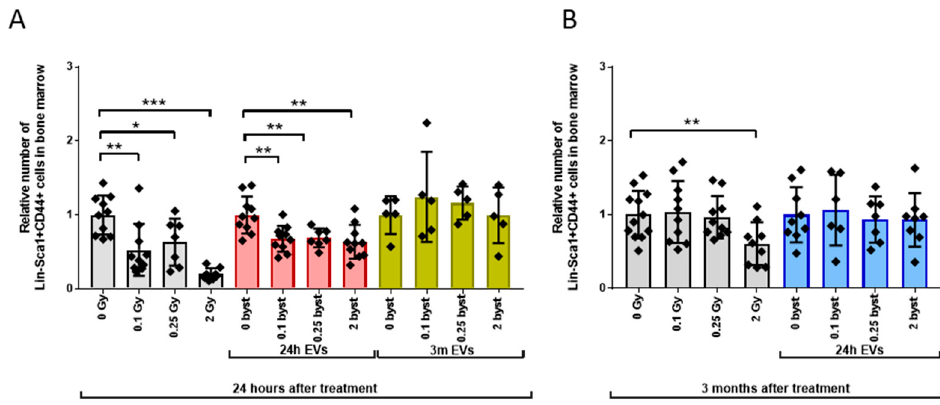
Figure 8. Short-Term Direct Irradiation and Extracellular Vesicle-Mediated Bystander Effects Affecting the Mesenchymal Stromal Cell Pool Are More Severe than Long-Term Effects. Irradiation, extracellular vesicle treatment and bone marrow cell phenotyping was done as described in the Materials and Methods section. Lin-Sca1+CD44+ cells were considered mesenchymal stromal cells. ( A ) Relative changes in mesenchymal stromal cell numbers were evaluated 24 h after treatment. Grey bars represent total-body irradiated mice; red bars represent mice treated with bone marrow-derived extracellular vesicles isolated from mice 24 h after irradiation; yellow bars represent mice treated with bone marrow-derived extracellular vesicles isolated from mice 3 months after irradiation. ( B ) Relative changes in mesenchymal stromal cell numbers were evaluated 3 months after treatment. Grey bars represent total-body irradiated mice; blue bars represent mice treated with bone marrow-derived extracellular vesicles isolated from mice 24 h after irradiation. Bars represent mean values of relative mesenchymal stromal cell numbers, dots show individual values, error bars represent SD. n = 5-11, significance tested by Student’s t -test, p * < 0.05, p ** < 0.01, p *** < 0.001.